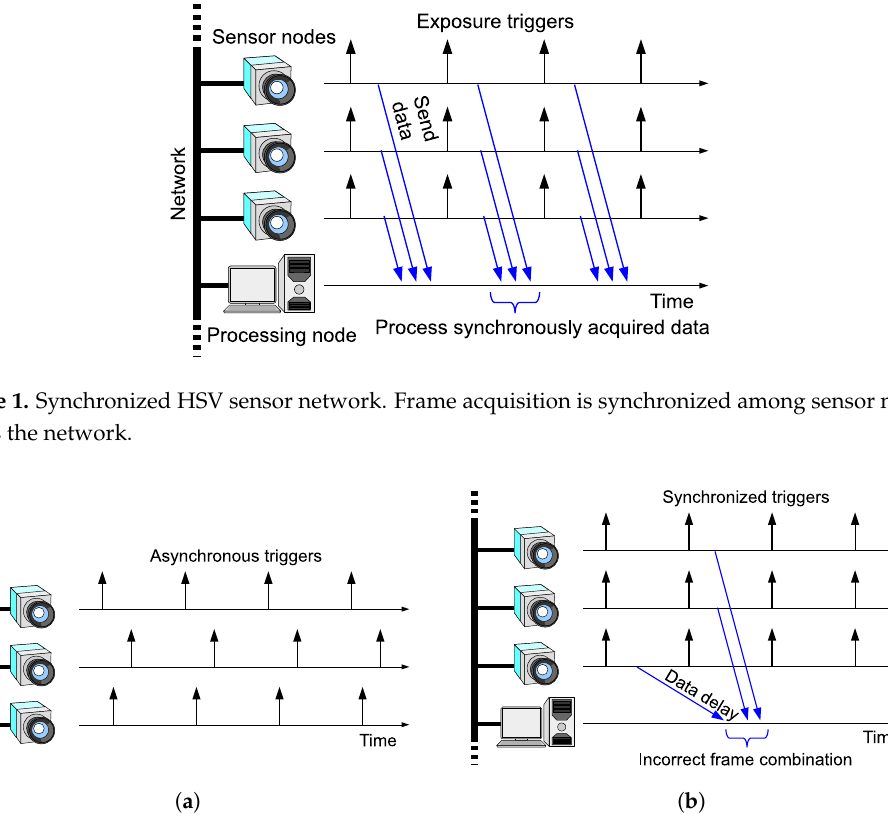
Figure 2. Frame synchronization problem with networked cameras. ( a ) Network latency directly degrades the synchronization accuracy if the trigger signals are transferred via the network. ( b ) Even if the frame acquisition timing is precisely synchronized, the data received via the network can be shuffled in a conventional packet-based network with random